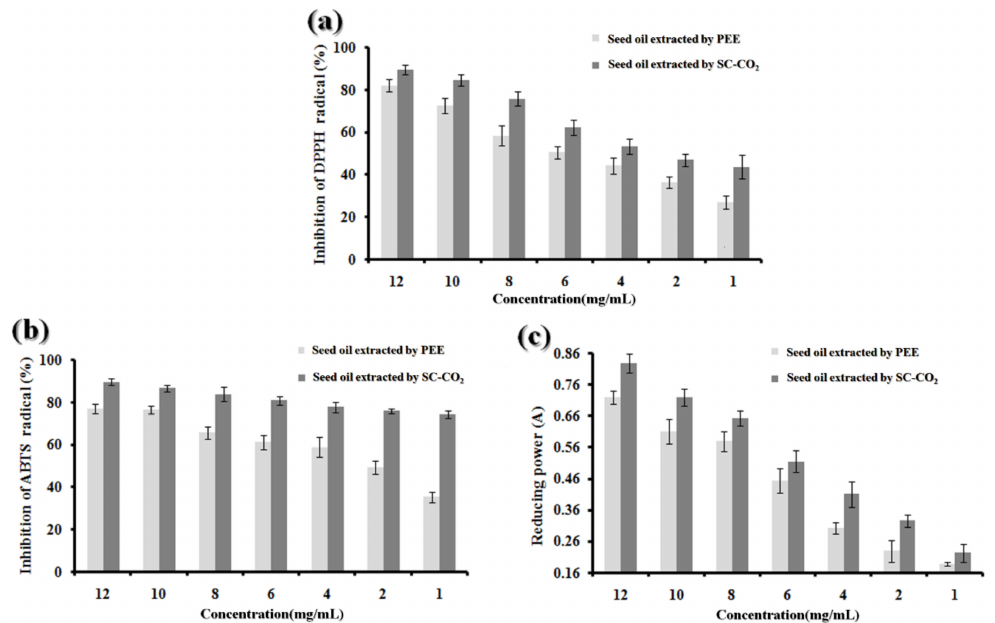
Figure 9. Activity of B. dasystachya seed oil obtained by di ff erent methods at di ff erent concentrations. ( a ) DPPH scavenging activity; ( b ) ABTS scavenging activity; ( c ) reducing power. Data are means ± SD ( n =